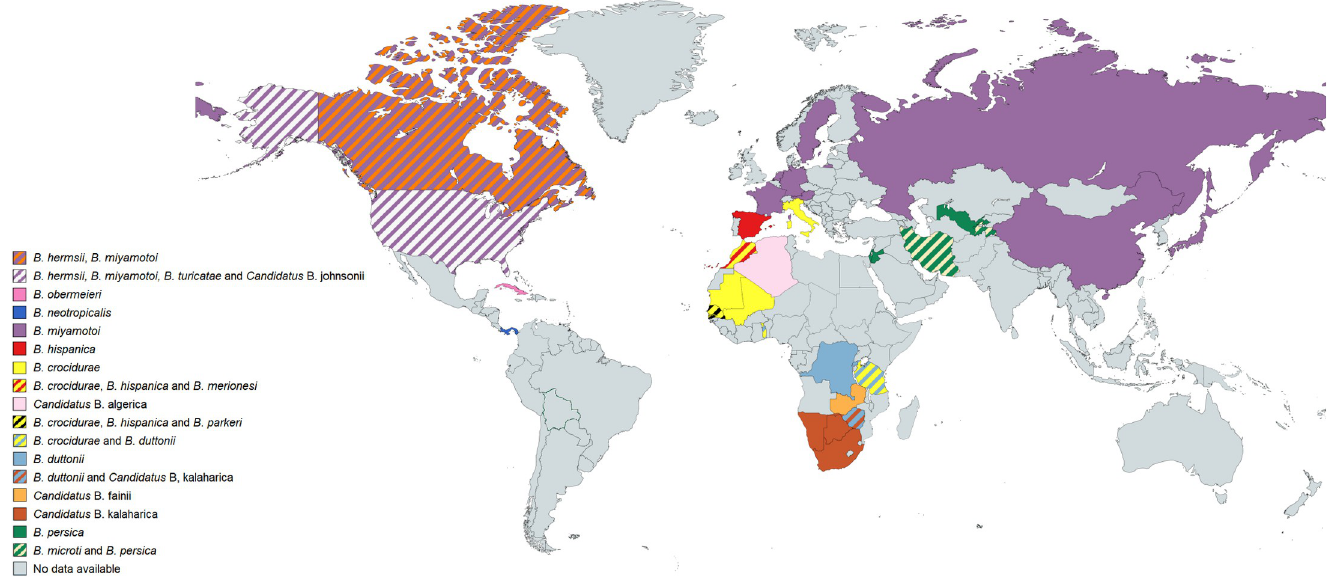
Fig 5. Reported TBRF cases by country and causative Borrelia species. B., Borrelia . Map created on www.mapchart.net. https://doi.org/10.1371/journal.pntd.0010212.g005 (based on detection in animal blood samples and/or ticks) is shown in Figs 7, 8, 9 and 10, respectively. The prevalence of competent vector ticks for TBRF Borrelia in America, Africa, Europe, and Asia can be found in S1 Fig.